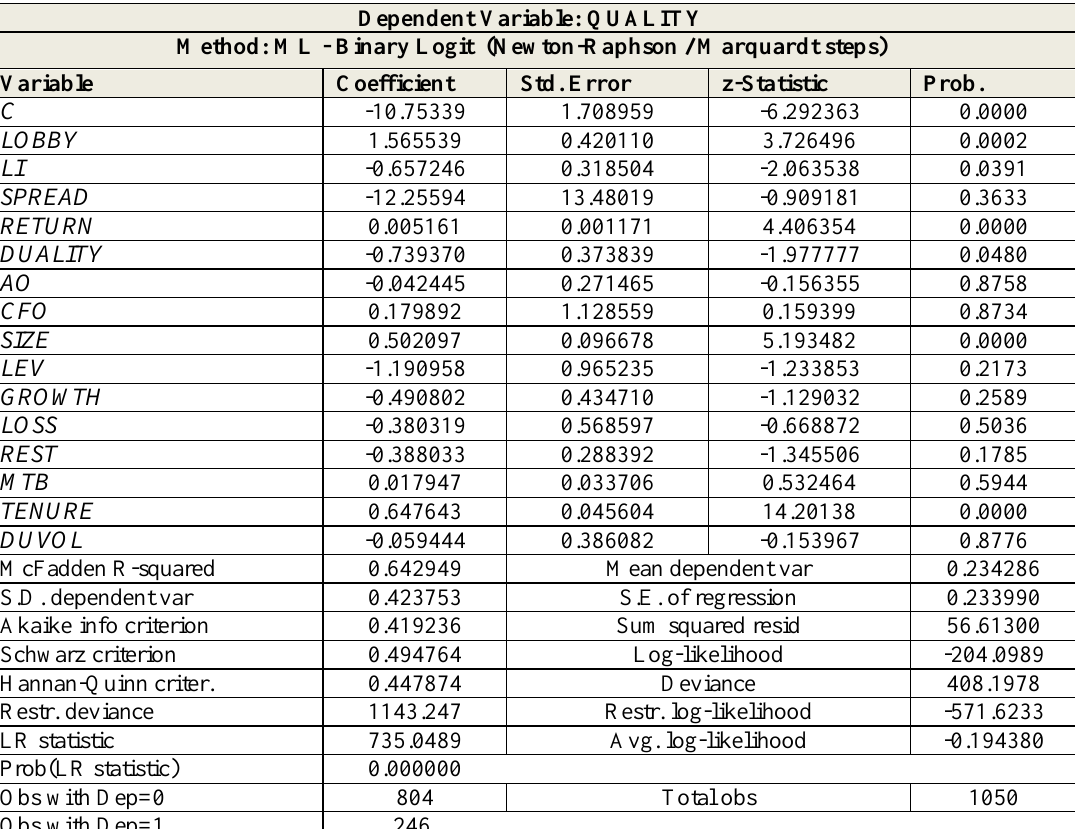
Table 7. Estimation results of model 2